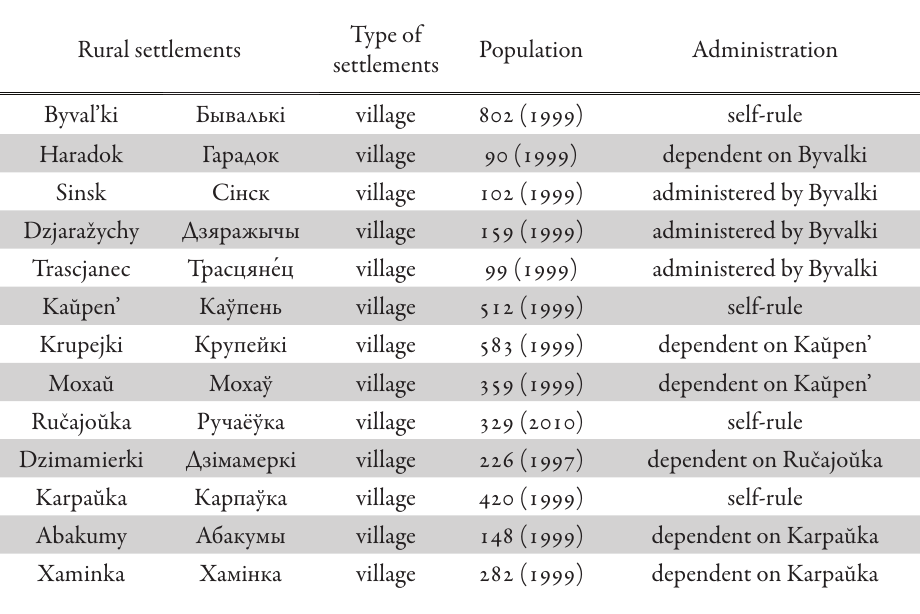
table 1. Villages in the district of Loeŭ (Belarus’) Rural